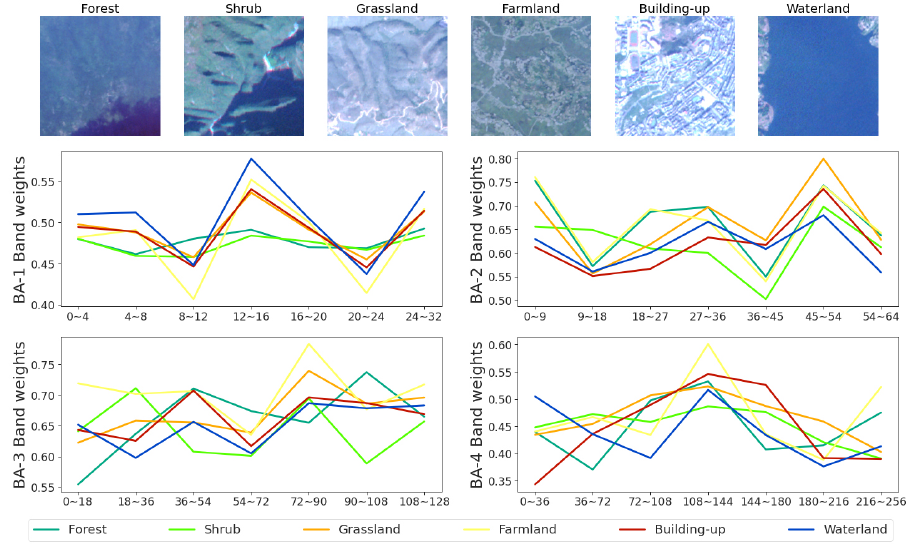
Figure 14. The band weights induced by the BA module at different depths in the proposed model. Six images from different categories were fed into the trained model and the weights for each band were class